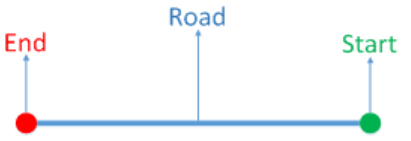
Figure 4. A road (edge) feature only has one start point and one end point, but no break point.